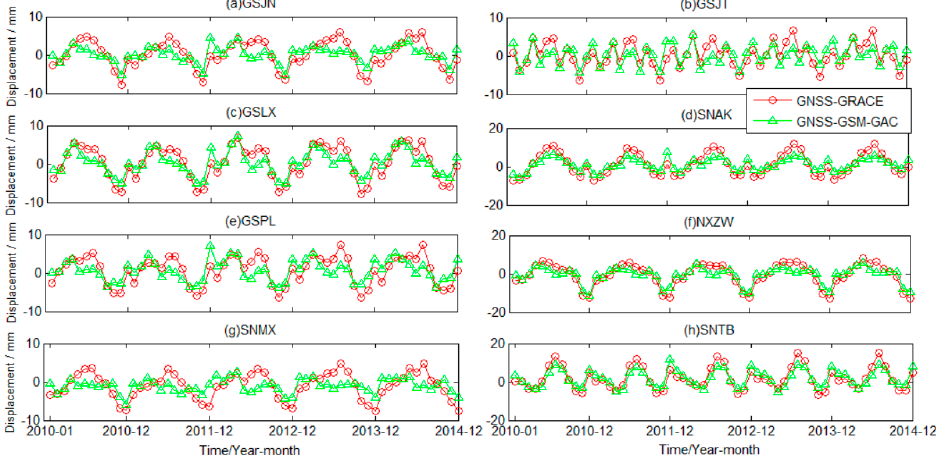
Figure 7. Residual sequences obtained by subtracting GRACE results before and after GAC correction from GNSS vertical displacement sequence.